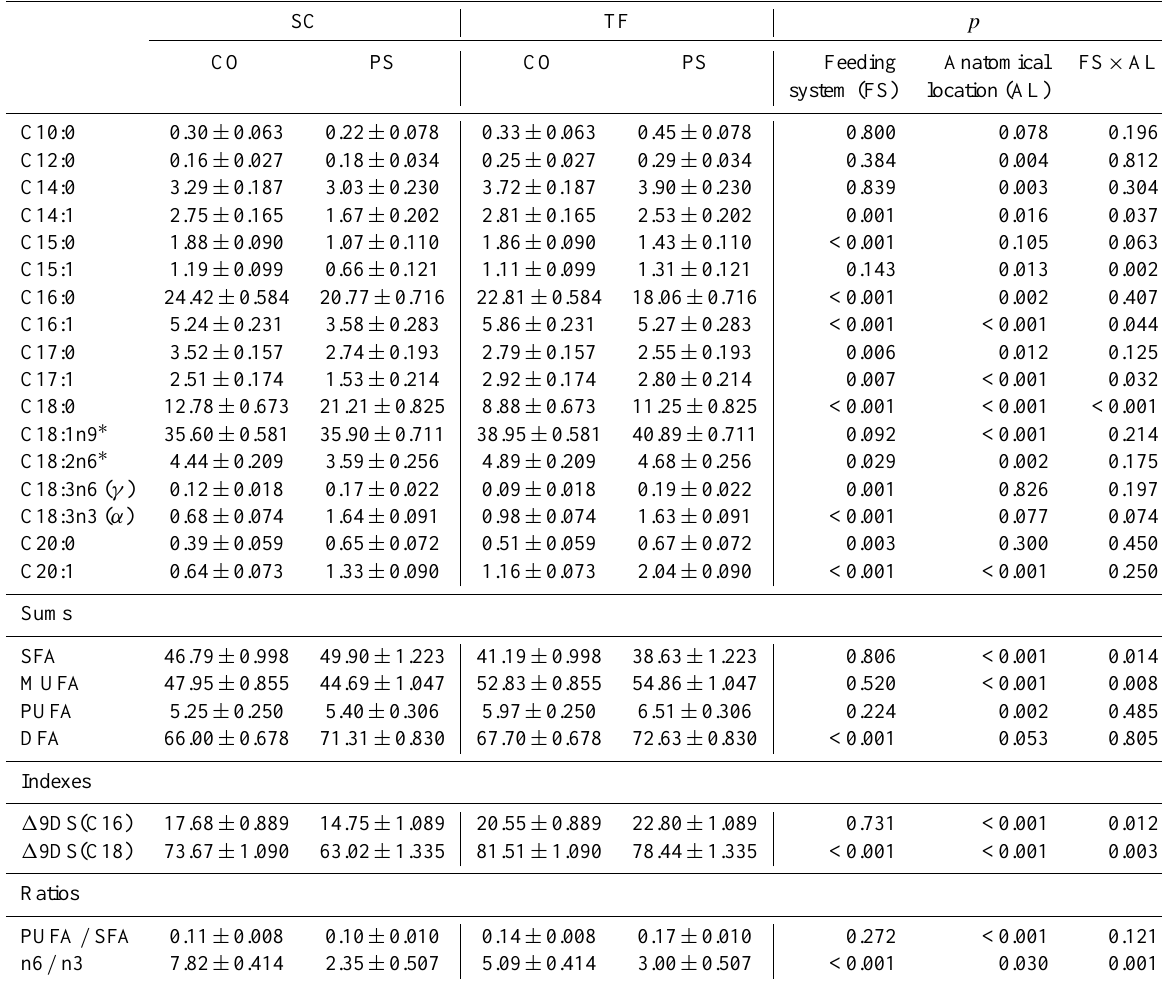
Table 4. Least square means for percentage of fatty acids in depot fat (subcutaneous (SC) and tail fat (TF)) of concentrate (CO) and pasture lambs